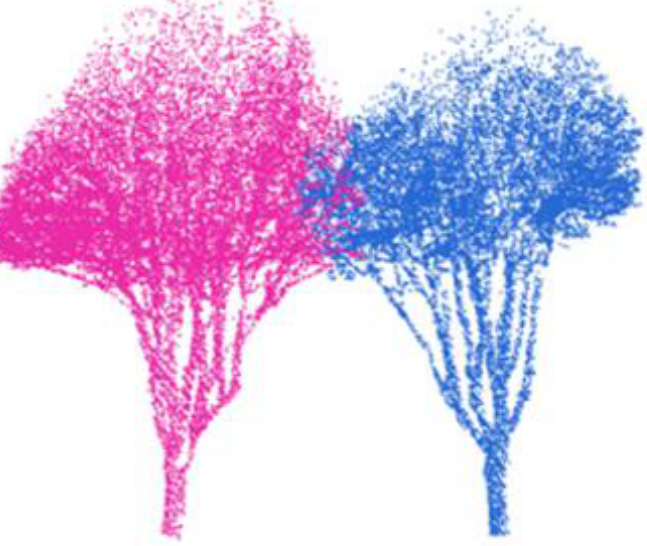
Figure 6. Individual trees extraction result. The different colors represent different individual tree.